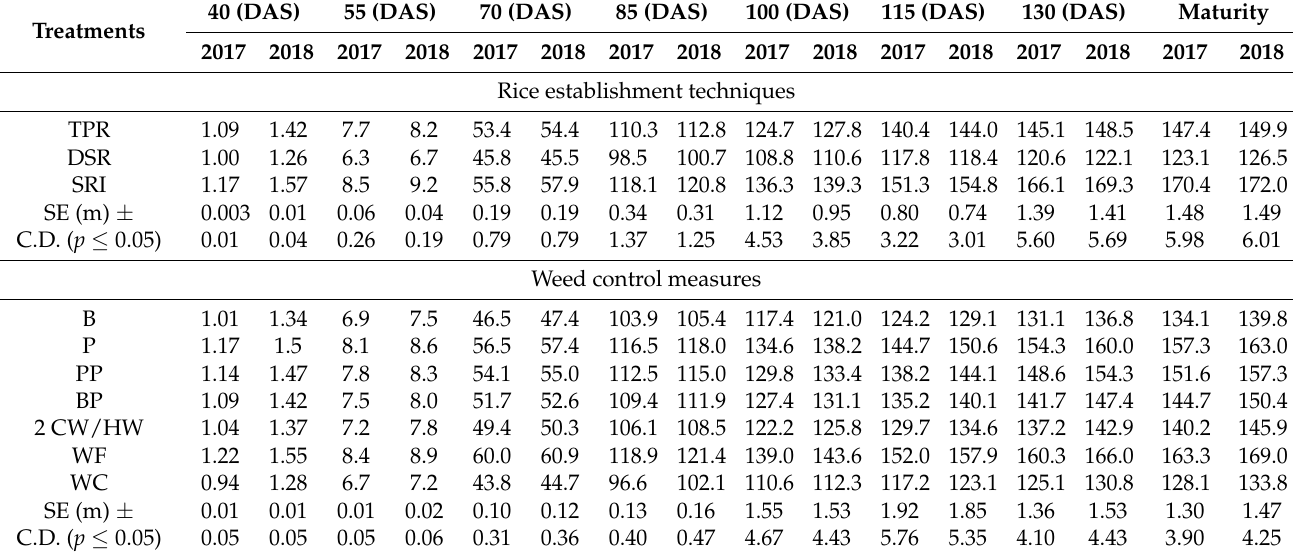
(Table 2). SRI performed better than TPR and DSR, with dry matter accumulation of 17.04 and 17.20 t ha − 1 at harvest, respectively. In contrast, direct-seeded rice had the lowest dry matter accumulation of 12.31 and 12.65 t ha − 1 at 2017 and 2018 (Table 1). SRI showed a 13.48 and 27.75 percent increase in dry matter accumulation than transplanted and direct-seeded rice at harvest in 2017, and the comparable figures for 2018 were 12.83 and 26.43 percent, respectively. However, as compared to other herbicides, the plots under Penoxsulam herbi- cide significantly recorded the higher dry matter accumulation of 15.73 and 116.30 t ha − 1 , with a percentage increase of 18.59 and 17.94 percent when compared to weedy check during 2017 and 2018, respectively. Table 2. Dry biomass (qha − 1 ) of rice crop as influenced by rice establishment techniques and weed control